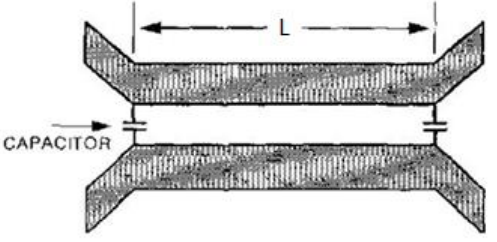
Figure 1. Microstrip directional coupler with symmetric compensating capacitors